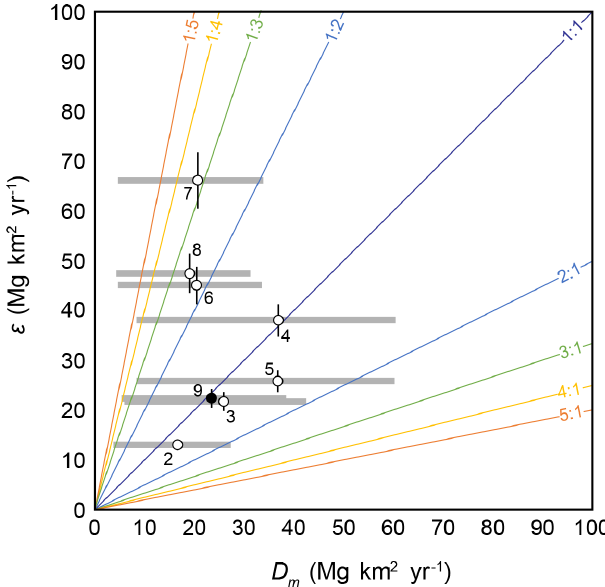
Figure 8. 10 Be i -based erosion rates ( ε ) compared 10 Be m / 9 Be reac - based denudation rates ( D m ) for tributary basins (open circles) and the trunk channel site, TG-9 (closed circle). Measures of ε and D m are different at each site, but similar within a factor of 3. D m is cal- culated using a 9 Be parent value of 4.1ppm, taken from average val- ues of a suite of biotite granites across the former Soviet Union and China (Beus, 1962; also reported in Sainsbury, 1964); horizontal grey bars, however, show the range of D m values calculated using low estimates of crustal 9 Be parent (2.5ppm; high end of D m values; von Blanckenburg et al., 2012) and the average measured 9 Be parent values of S-type and tin-bearing granites (18ppm; n = 11; low end of D m values; London and Evanson, 2002).